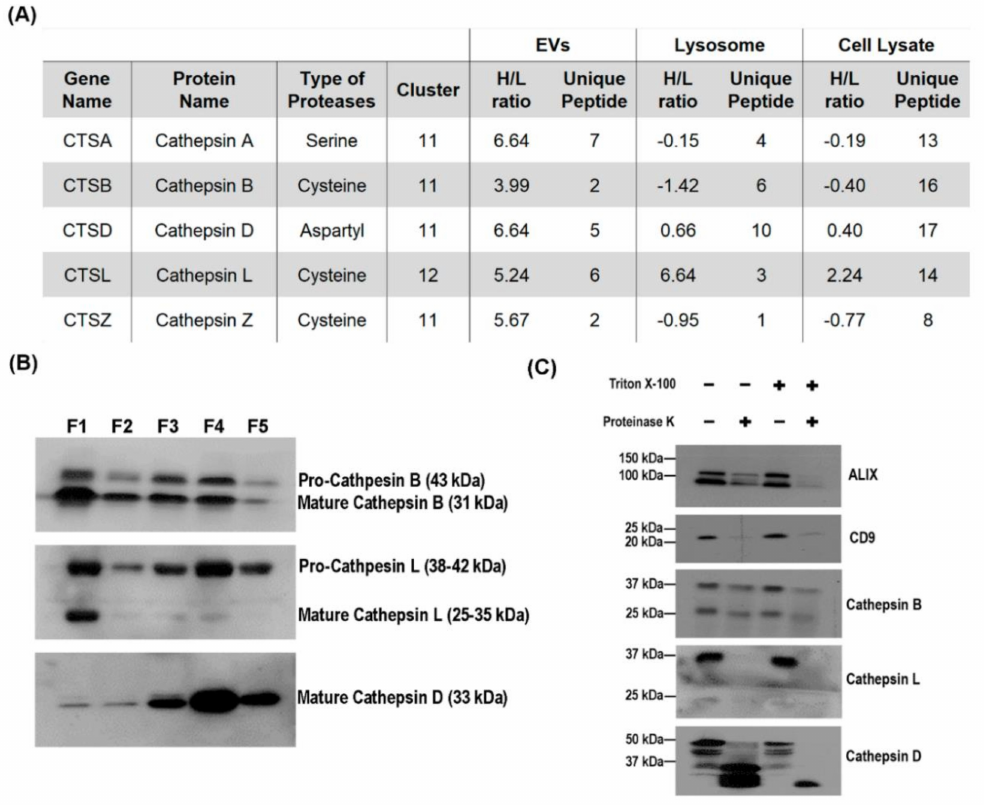
Figure 3. Actively synthesized cathepsin proteins are sorted into mHypoA 2 / 28 EVs. ( A ) List of cathepsin proteins identified in the three proteomic datasets. ( B ) Location of CTSB, CTSD and CTSL along the endo-lysosomal compartment. mHypoA 2 / 28 cell lysate was separated on a density gradient (based on Figure 1B) and five fractions were collected. 20 µ l from each fraction was used for immunoblotting analysis. ( C ) Proteinase K protection assay was performed to determine the distribution of cathepsin proteins on the EVs. Intact mHypoA 2 / 28-derived EVs were incubated in either PBS, 10 µ g / mL of Proteinase K, 1% Triton X-100 or 10 µ g / mL of proteinase K with 1% Triton X-100 for 1 h at 37 ◦ C. Immunoblotting analysis revealed the localization of CTSB, CTSD and CTSL on the EVs. ALIX is a marker for luminal EVs protein while CD9 is a membrane bound EVs